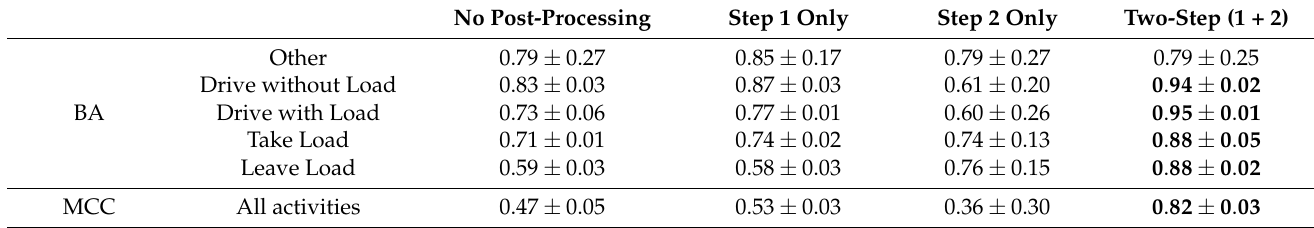
Table 2. Classification results of the RFs on top of different representations (mean ± 2 × std); boldface indicates the best performance (statistical significance) in each